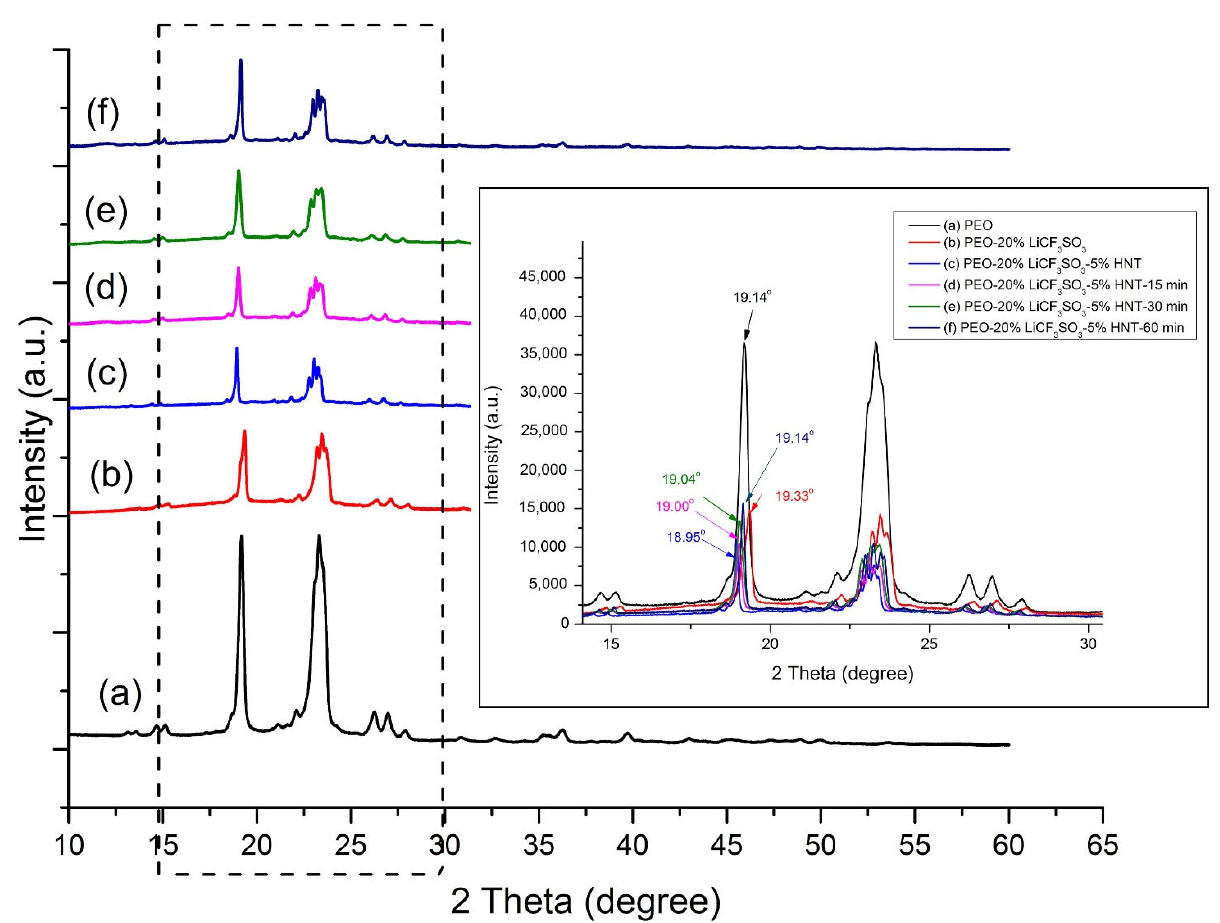
Figure 6. XRD patterns of ( a ) As − received PEO, ( b ) PEO − 20%LiCF 3 SO 3 , ( c ) PEO − 20%LiCF 3 SO 3 − 5%HNT, ( d ) PEO − 20%LiCF 3 SO 3 − 5%HNT − 15 min, ( e ) PEO − 20%LiCF 3 SO 3 − 5%HNT − 30 min and ( f ) PEO 20%LiCF 3 SO 3 5%HNT 60 min.